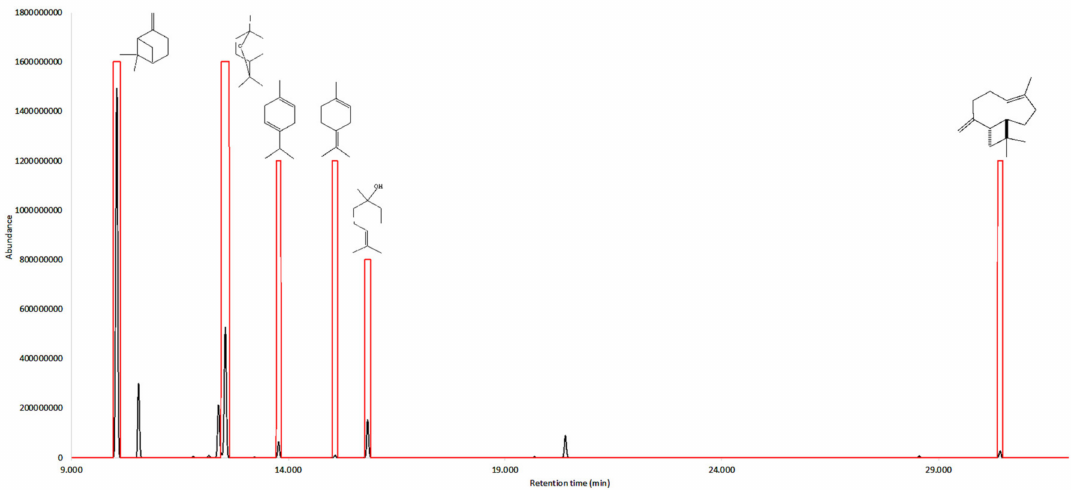
Figure 2. Gas chromatogram (black line) vs. aromagram (red line) of the essential oil from M.